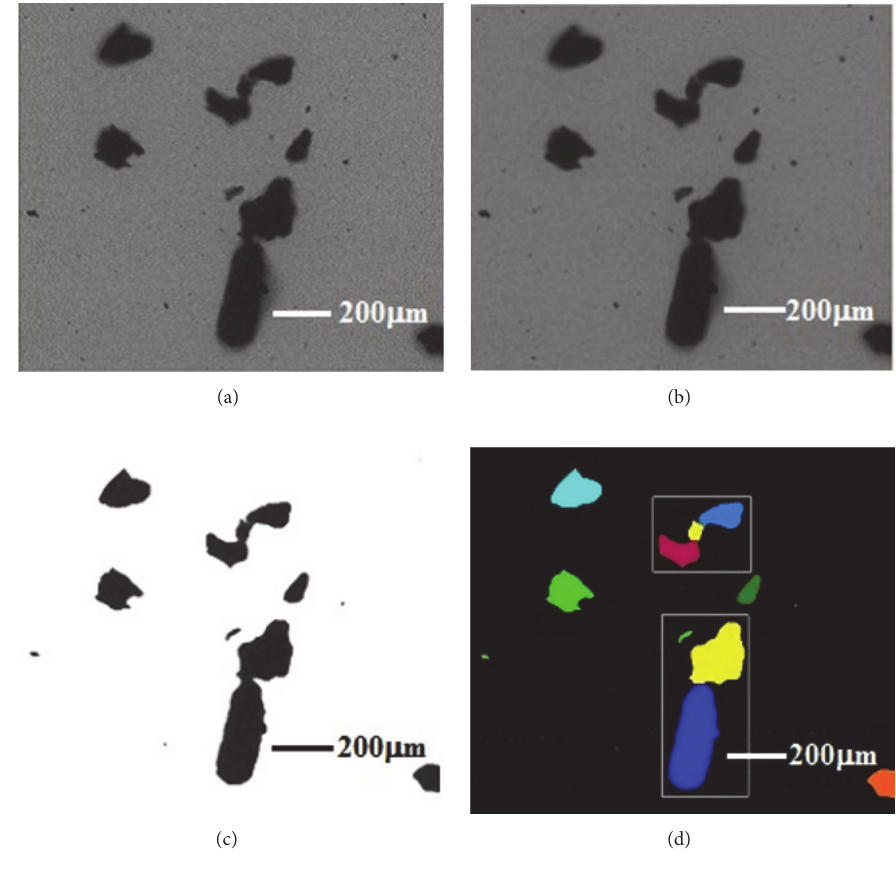
Figure 4: Processing results corresponding to each step.